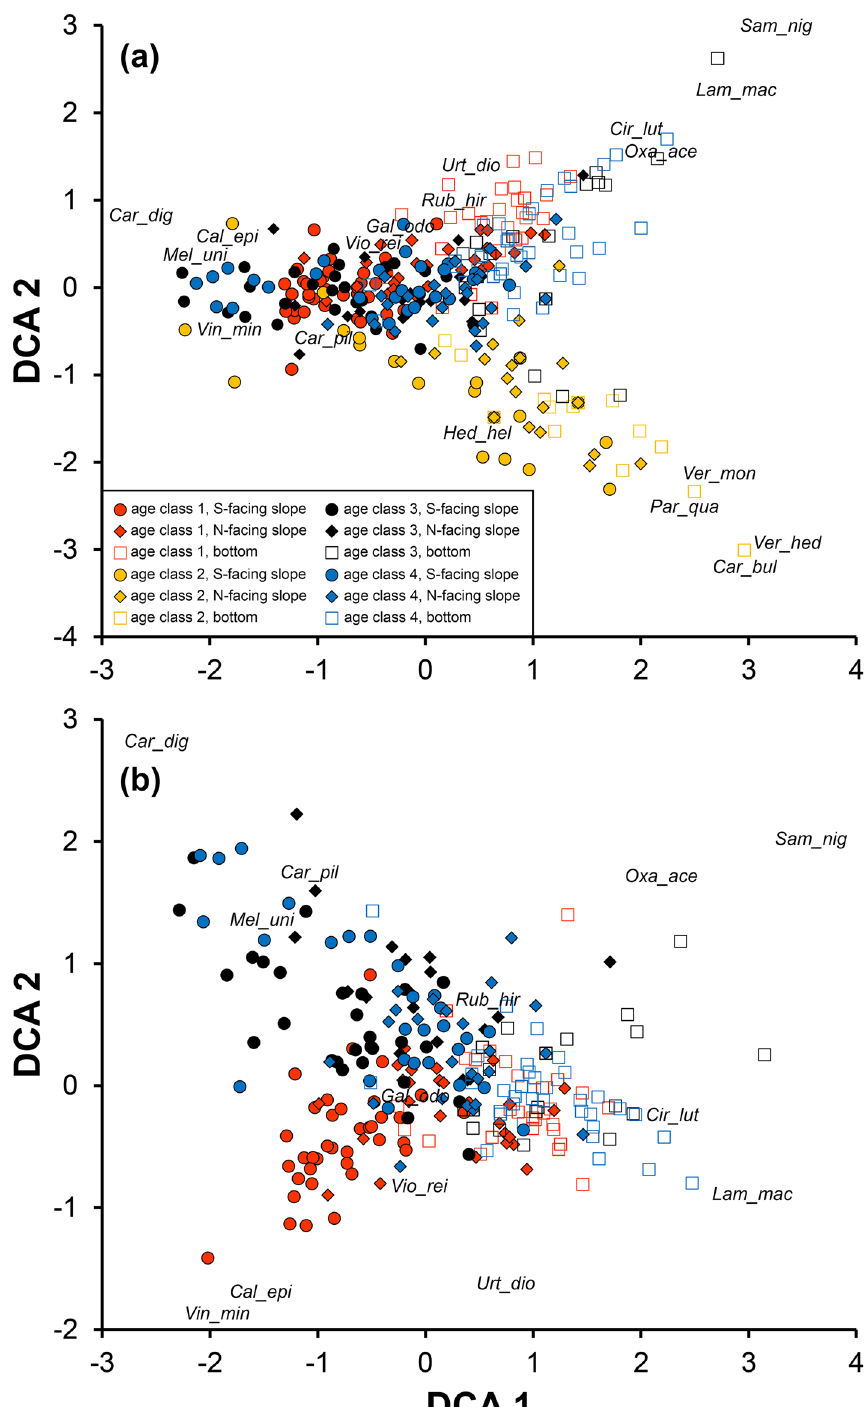
Fig. 3 Detrended correspondence analysis (DCA) for the plots of dolines ( a all plots and b plots of classes 1, 3, and 4) with some important diagnostic species of the topographic positions of the forest age classes (see Table 3). Abbreviations for species are as follows: Cal_epi, Calamagrostis epigejos ; Car_dig, Carex digitata ; Car_pil, Carex pilosa ; Car_bul, Cardamine bulbifera ; Cir_lut, Circaea lutetiana ; Gal_odo, Galium odoratum ; Hed_hel, Hedera helix ; Lam_mac, Lamium maculatum ; Mel_uni, Melica uniflora ; Oxa_ace, Oxalis acetosella ; Par_qua, Paris quadrifolia ; Rub_hir, Rubus hirtus agg.; Sam_nig, Sambucus nigra ; Urt_dio, Urtica dioica ; Ver_mon, Veronica montana ; Ver_hed, Veronica hederifolia ; Vin_min, Vinca minor ; Vio_rei, Viola